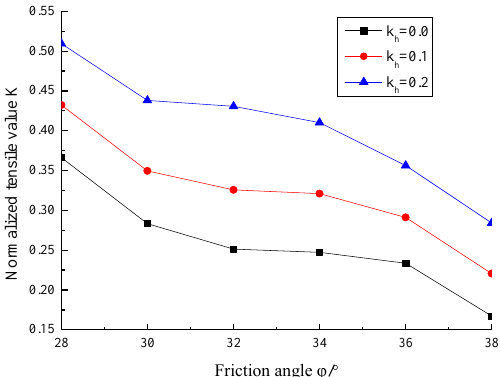
Appl. Sci. 2019 , 9 , x FOR PEER REVIEW Figure 5. Normalized tensile force of reinforcement under seismic load when k v = 0.5 k h .